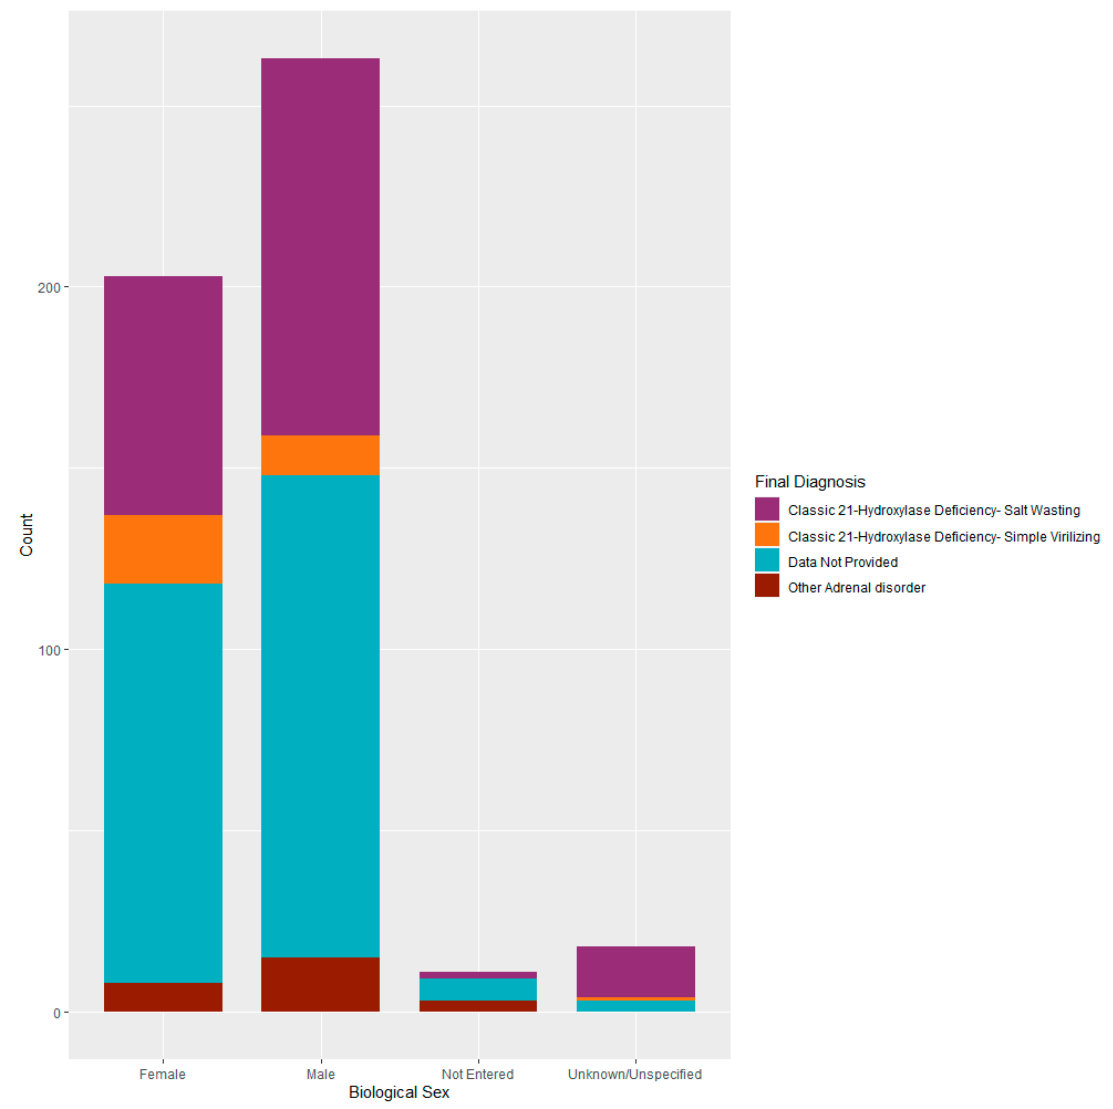
Figure 6. Congenital adrenal hyperplasia cases: final diagnosis by biological sex from 2015 to 2017 ( N =